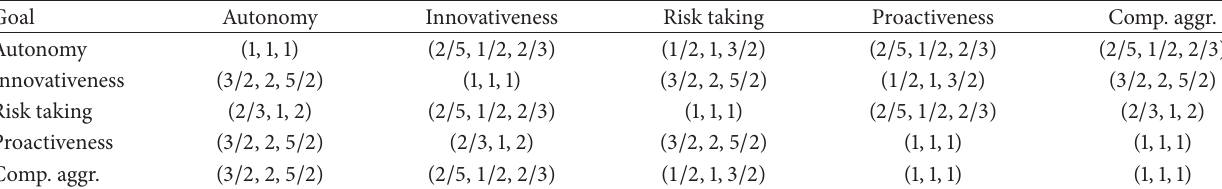
Table 3: Fuzzy pairwise comparisons of the main